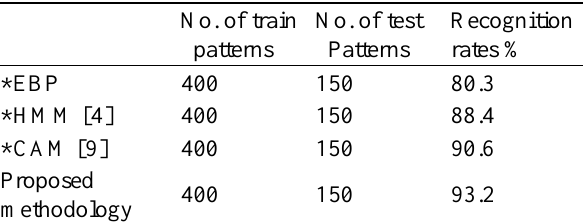
Table 6. The compared results of different